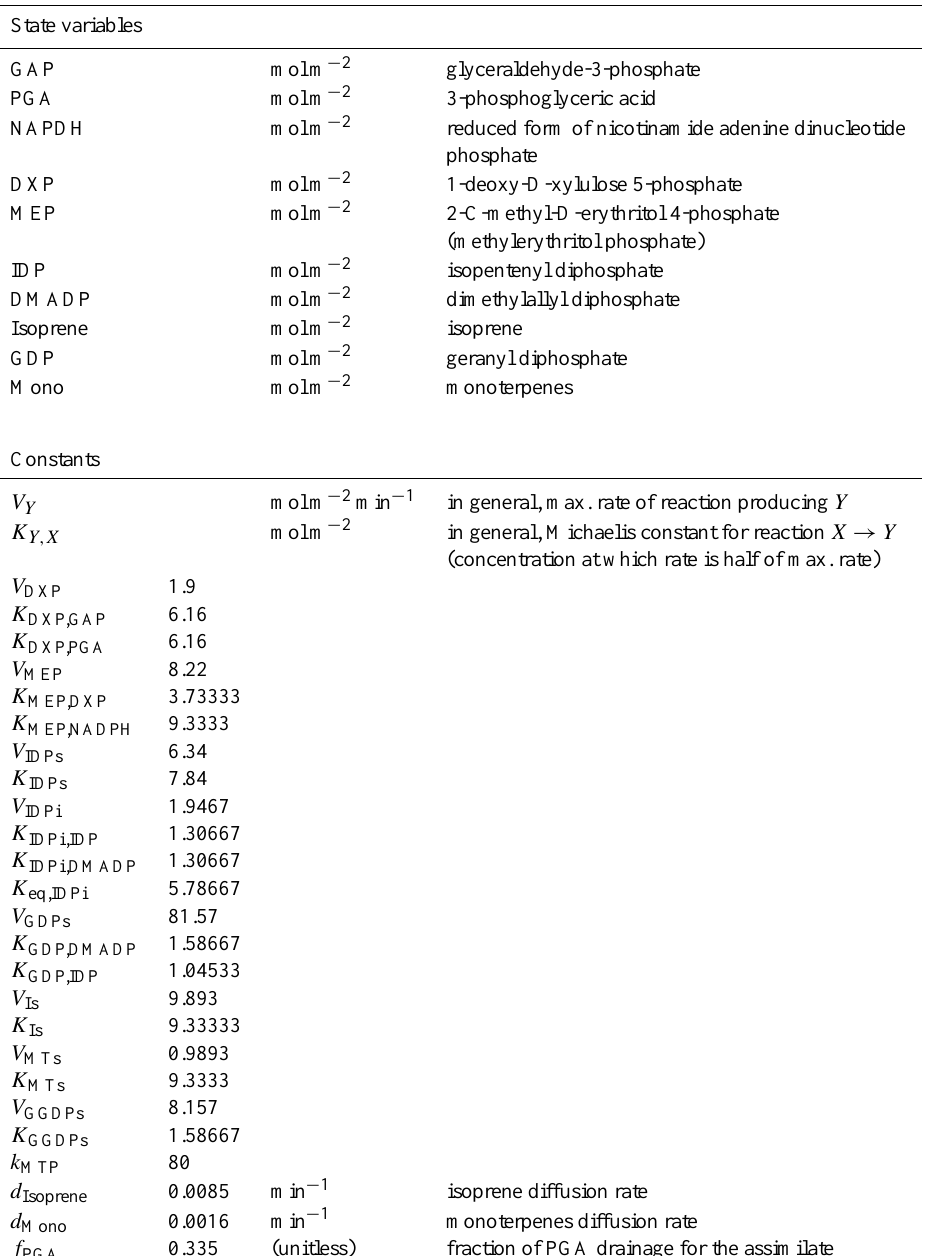
Table A2. SIM–BIM BVOC emission model variables and constants with